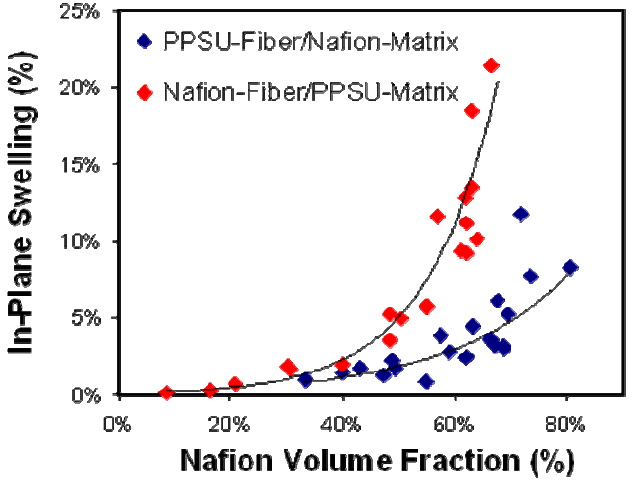
Figure 10. Comparison of Vanderbilt University’s in-plane swelling for polyphenylsulfone (PPSU)/Nafion and Nafion/PPSU nanofiber membranes in 100 °C water as a function of Nafion volume fraction